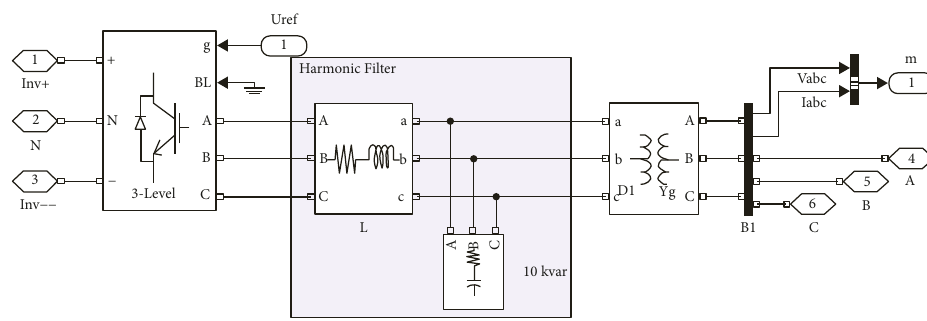
Figure 13: Three-level NPC.